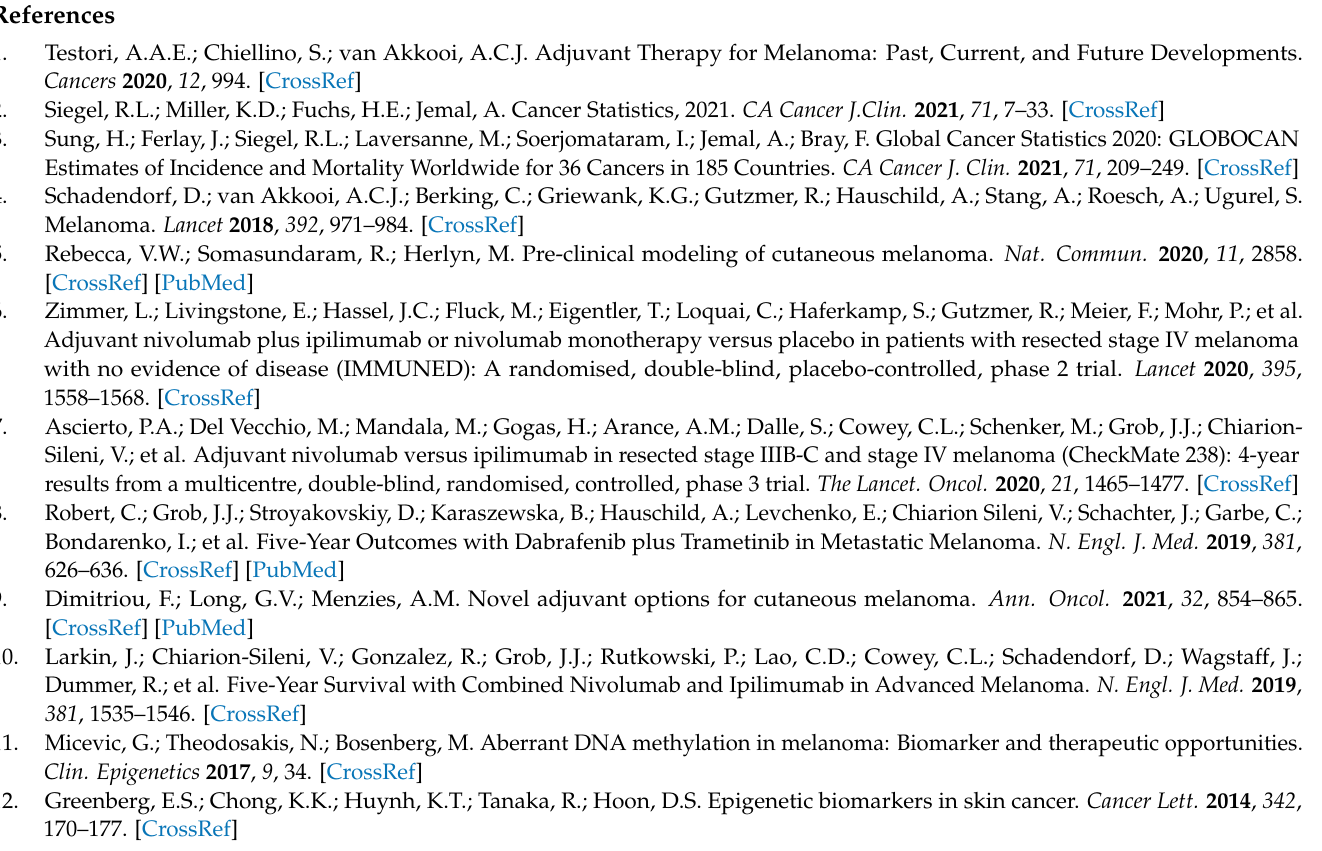
IV metastatic melanoma from TCGA SKCM dataset, Table S1: Clinicopathological characteristics and H-score values detected by IHC for stage IV melanoma patients, Table S2: Associations between clini- copathological characteristics and H-score values detected by IHC for stage IV melanoma